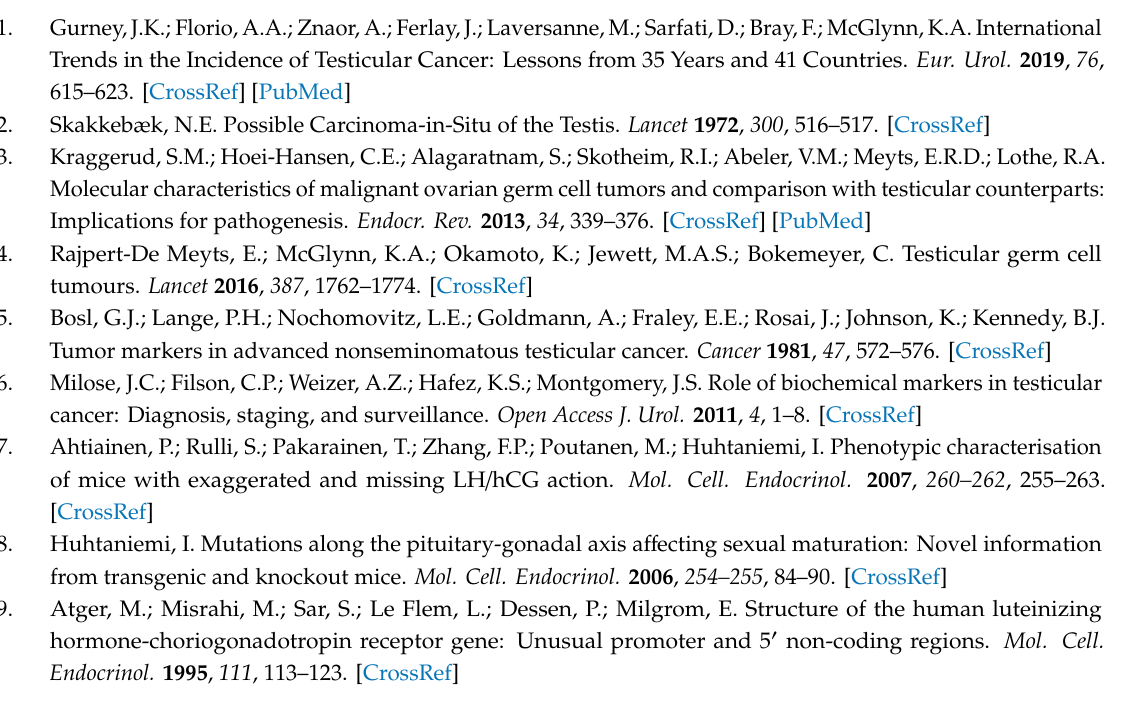
Table S1: Antibodies and conditions used for IHC and